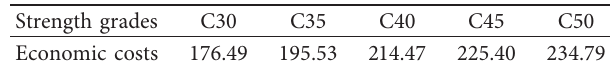
Table 11: Economic cost optimization of different strength grades coal gangue-based geopolymer concrete based on Chebyshev mapping optimization (yuan/m 3